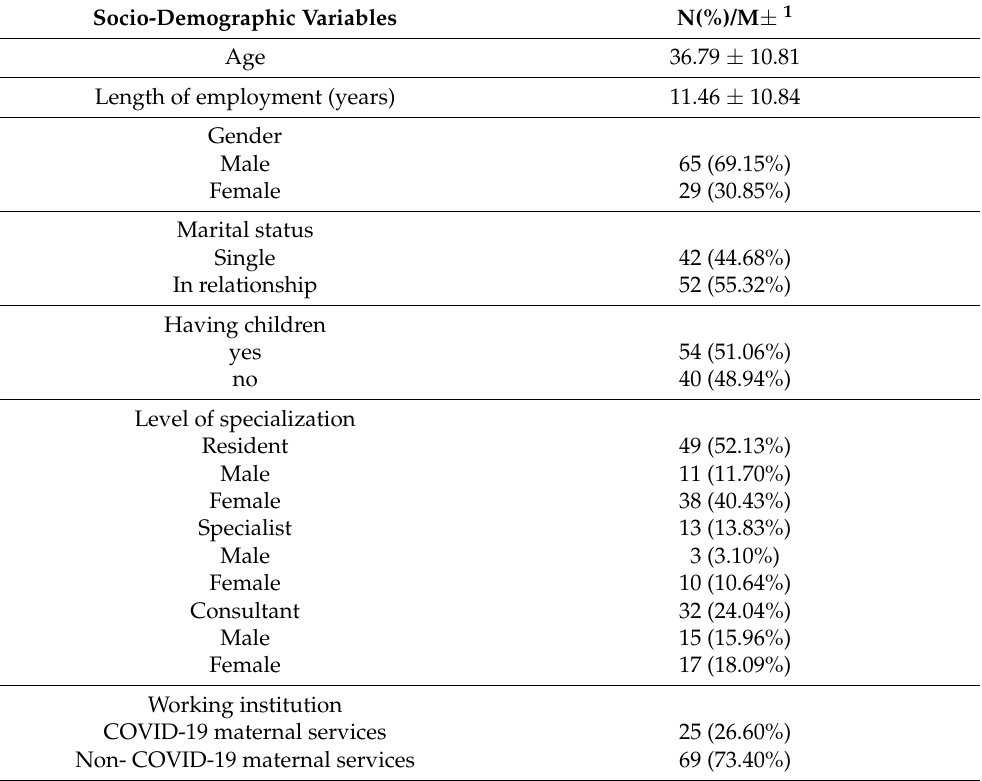
Table 1. The distribution of respondents considering the gender and professional level